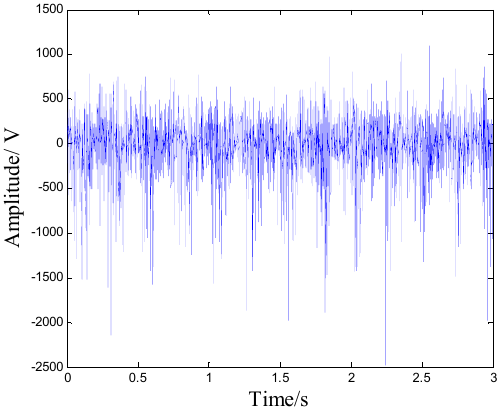
Figure 30. The time domain plot of normal gear.